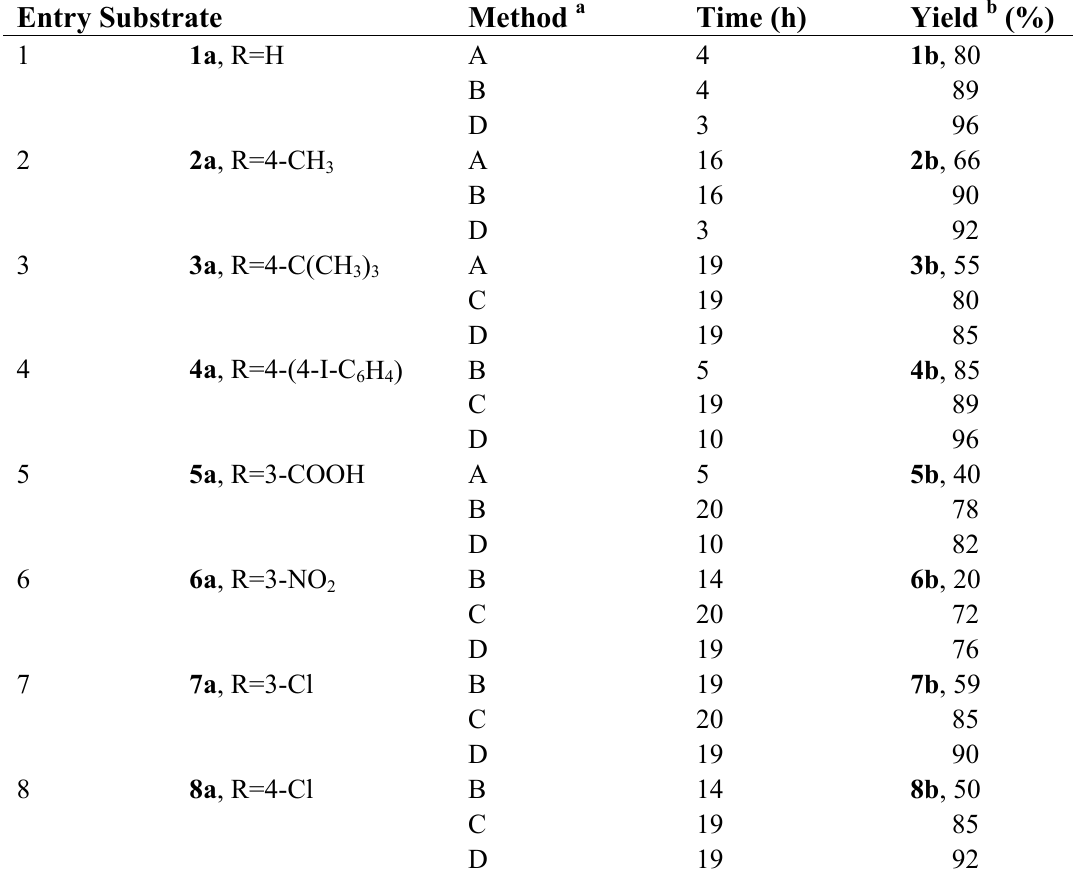
Table 1. Synthesis of Aryliodine(III) Dichlorides 1b–8b